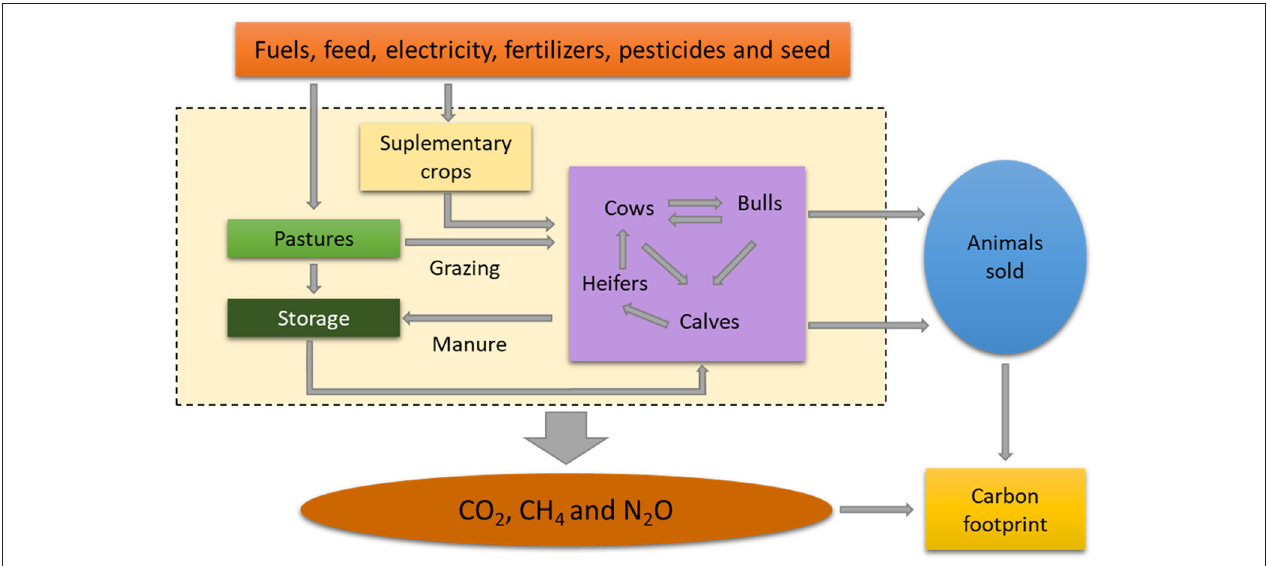
FIGURE 1 | System boundaries, greenhouse gas (GHG) sources, and storage (sinks) of the cow–calf system.